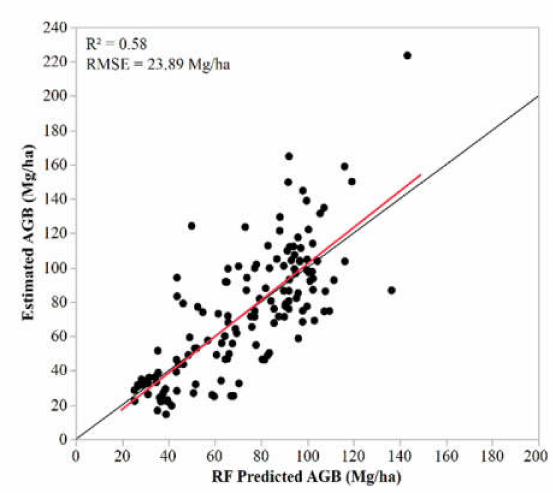
Figure 5. Scatterplot showing the relationship between ICESat-2 derived AGB and random forest (RF) predicted AGB with test data.